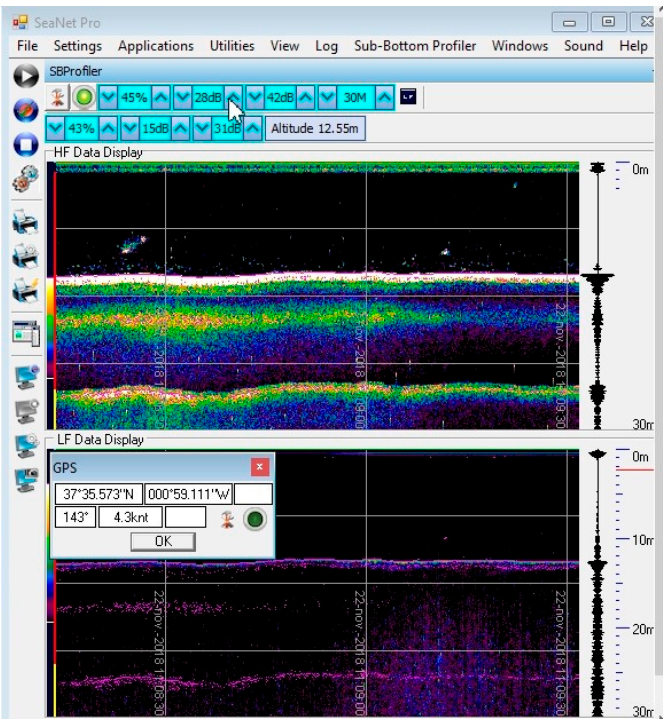
Figure 7. Sub-bottom profile image obtained.